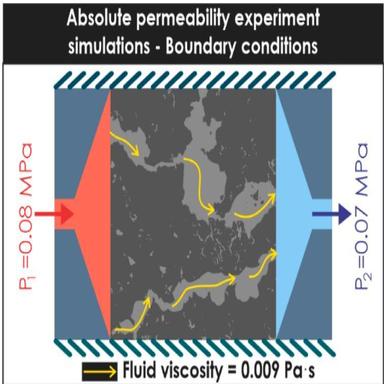
Schematic of boundary conditions used by XLab Suite Extension to estimate CGB graphite's absolute permeability.